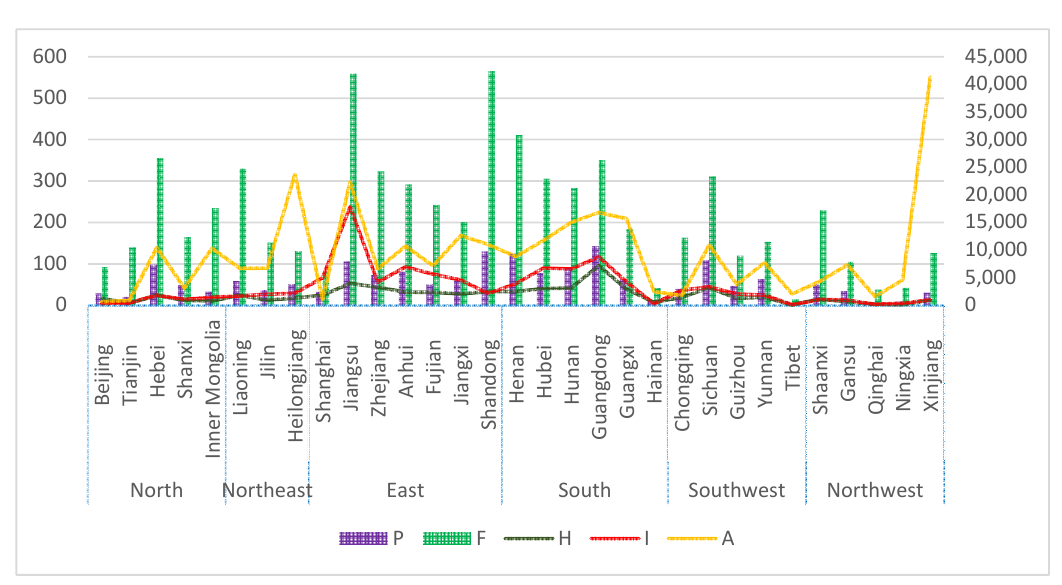
Figure 1. Water consumption in provincial regions.